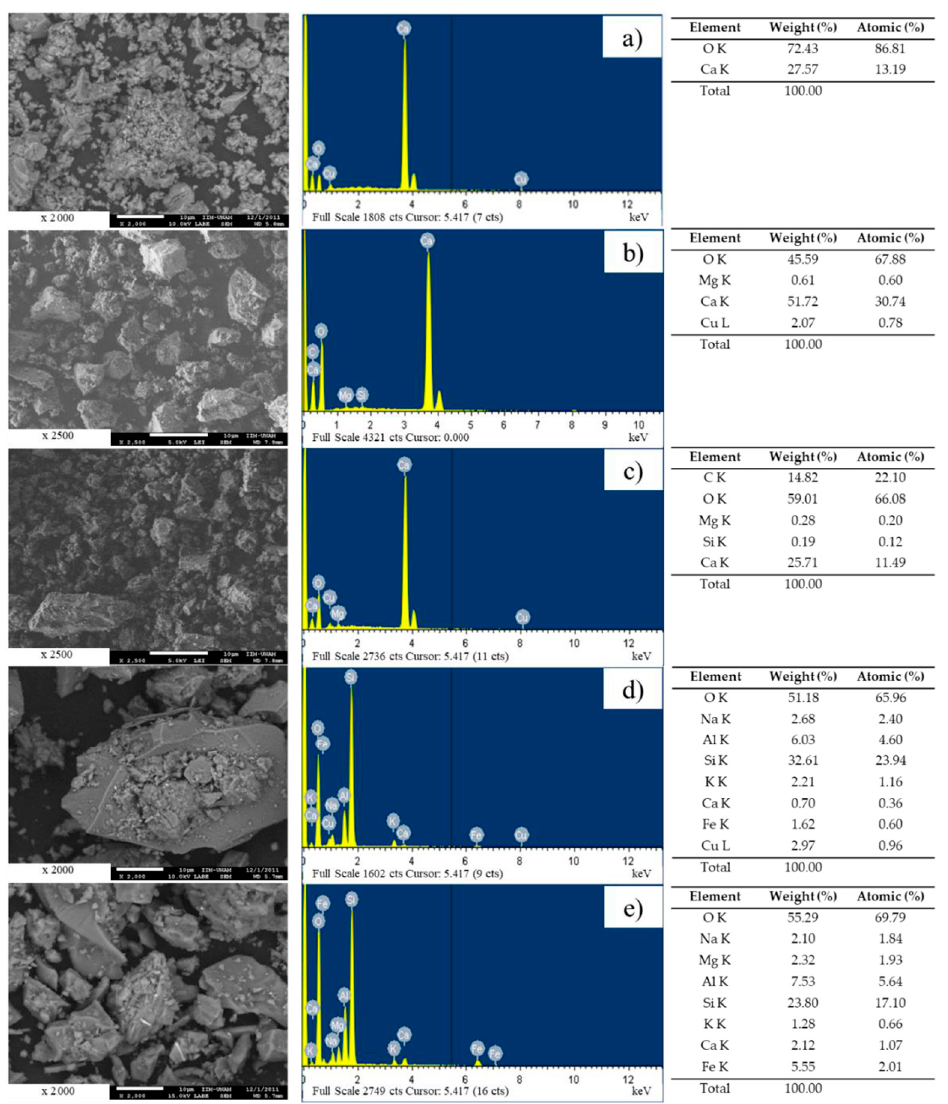
Figure 6. Scanning electron microscopy images of ( a ) lime; ( b ) CaCO 3 ; ( c ) Filler 1; ( d ) Filler 2 and ( e ) Filler 3.